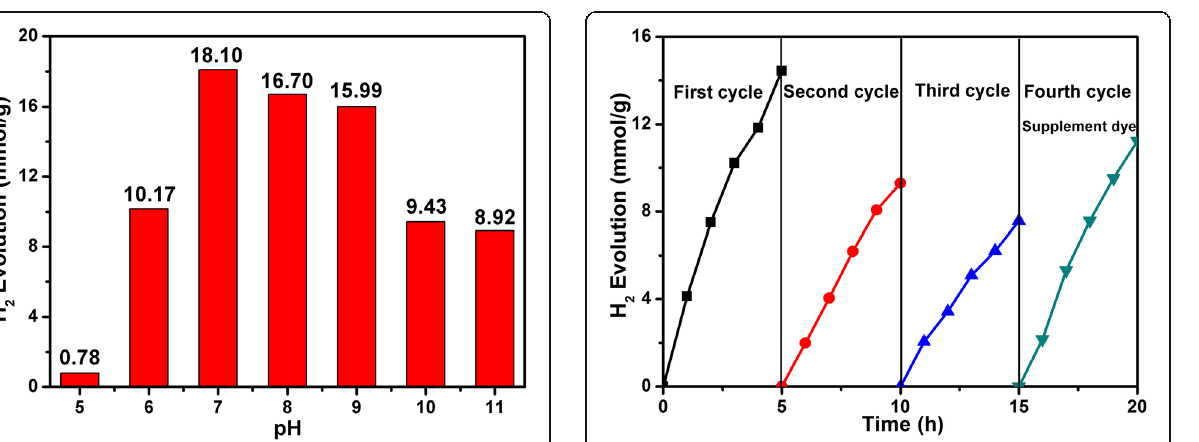
Fig. 9 Effect of the pH on the photocatalytic activity of Pd/MOF 3% (10 mg) for hydrogen evolution (reaction time 5 h, EY 20